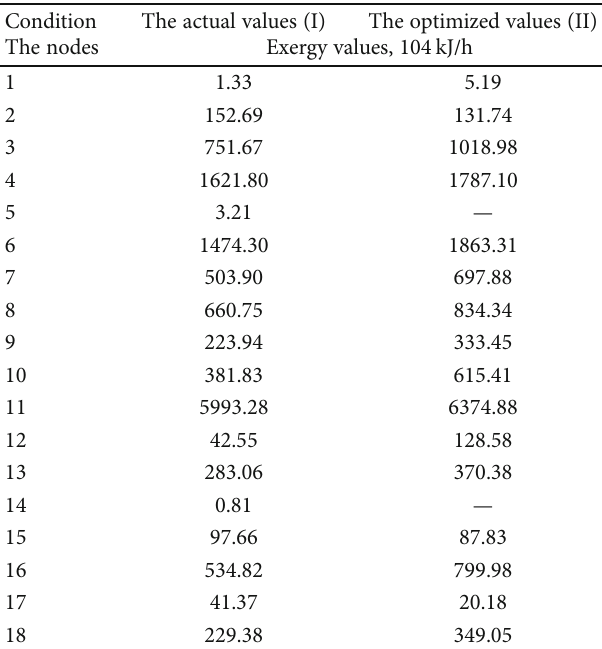
Figure 8: Analysis model of the process. A: regeneration unit; B: absorption unit; C: heat exchange unit; D: drying unit; E: compression unit. Table 5: Analysis result of the process ’ s exergy.